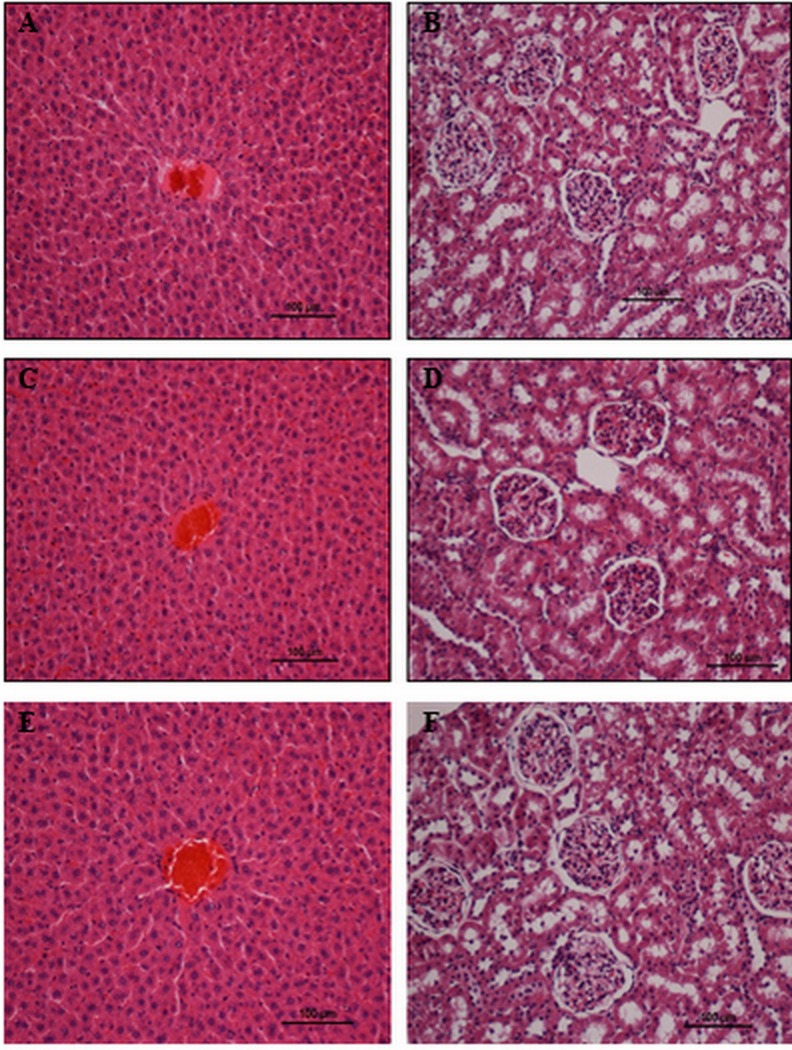
Liver and kidney histology of the acute toxicity assay.(A and B) Rats fed with 5 mL/kg of vehicle (10% Tween 20). (C and D) Rats fed with 2 g/kg (5 mL/kg) of V. pubescens extract. (E and F) Rats fed with 5 g/kg (5 mL/kg) of V. pubescens extract. There were 6 rats in each group of experiment. No significant changes were observed between the treated and vehicle control groups (Hematoxylin and Eosin stain).